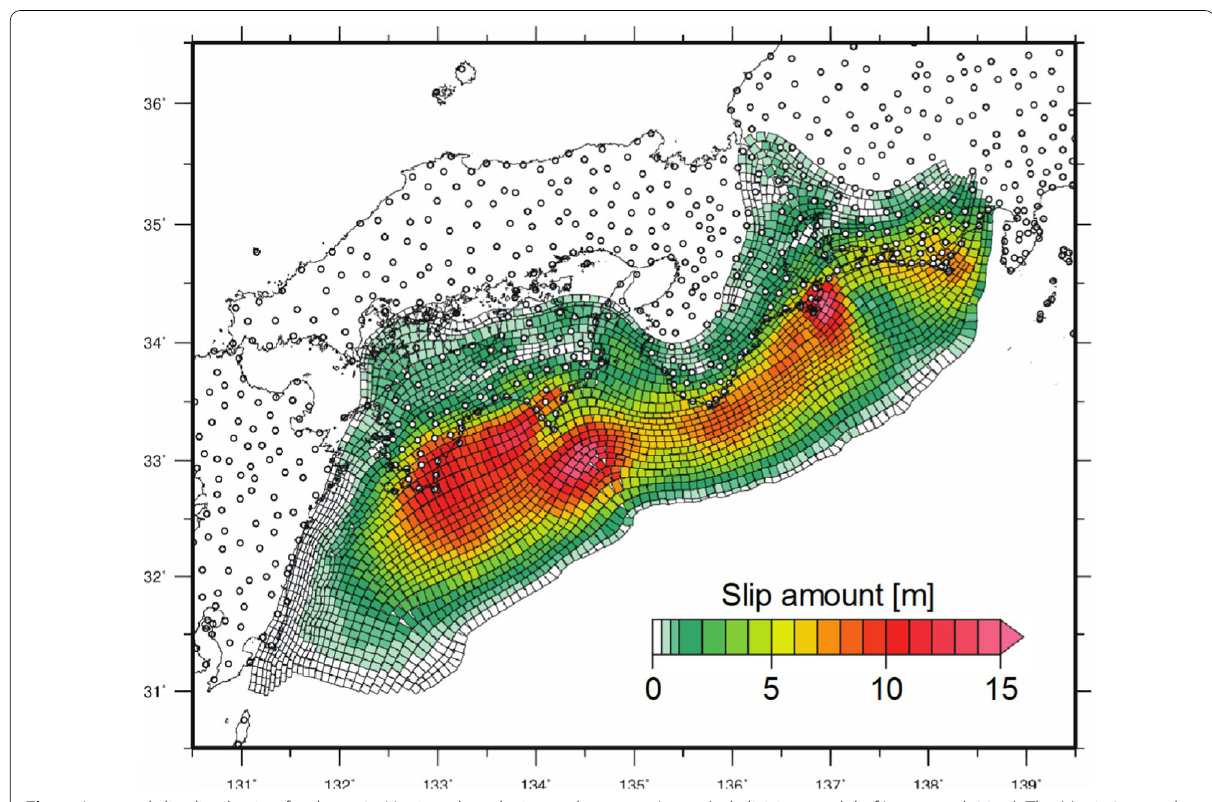
Fig. 1 Inputted slip distribution for the 1707 Hoei earthquake in southwestern Japan (subdivision model of Inoue et al. 2016). The Mw is 8.75 and the color scale indicates the slip amount along each subfault. White dots indicate the 642 continuous Global Navigation Satellite System (GNSS) network (GEONET) stations, with displacements calculated using Okada (1992). The width of rectangular subfaults is approximately 8